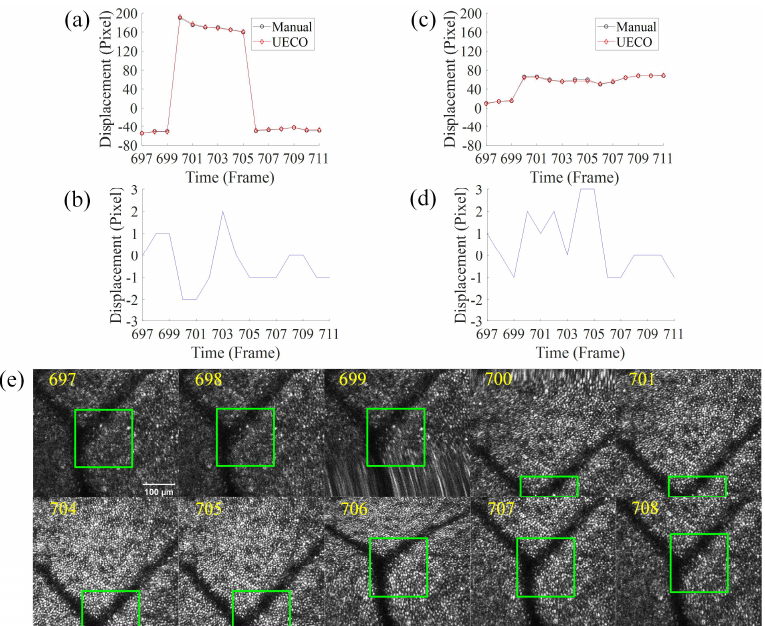
Figure 9. Comparison of displacement under saccadic eye motion; ( a , c ) respectively show the comparison of vertical and horizontal displacement obtained by manual registration and UECO under saccadic eye motion; ( b , d ) are the differences in the vertical and horizontal displacement between UECO and manual registration; and ( e ) is 10 frames in an image sequence of saccadic eye motion. The green box is the UECO reference and the yellow text in the graph represents the current frame number. The frame number corresponds to the frame number in the original video. The scale bar is 100 µm.